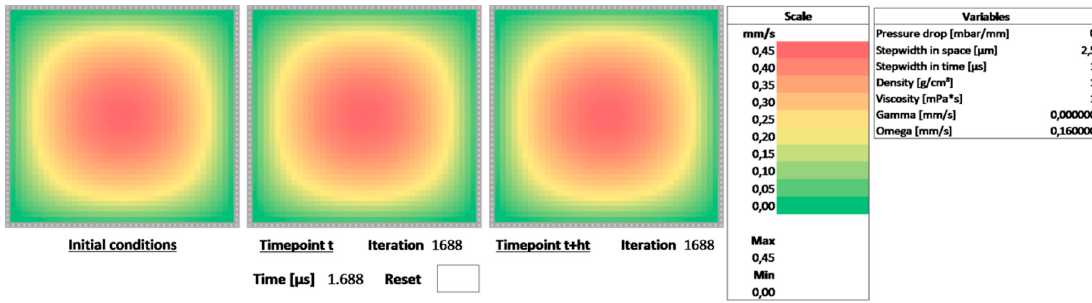
Figure 5. Example of a flow case using boundary conditions. The demonstrated case is a decelerating flow which was initially fully-defined as indicated by the initial conditions. At 𝑡 = 0 the driving pressure gradient is removed and the flow begins to stagnate. After more than 1500 iterations, the velocity profile is smeared and the velocity profile drops to maximum values below 0.5 mm/s.